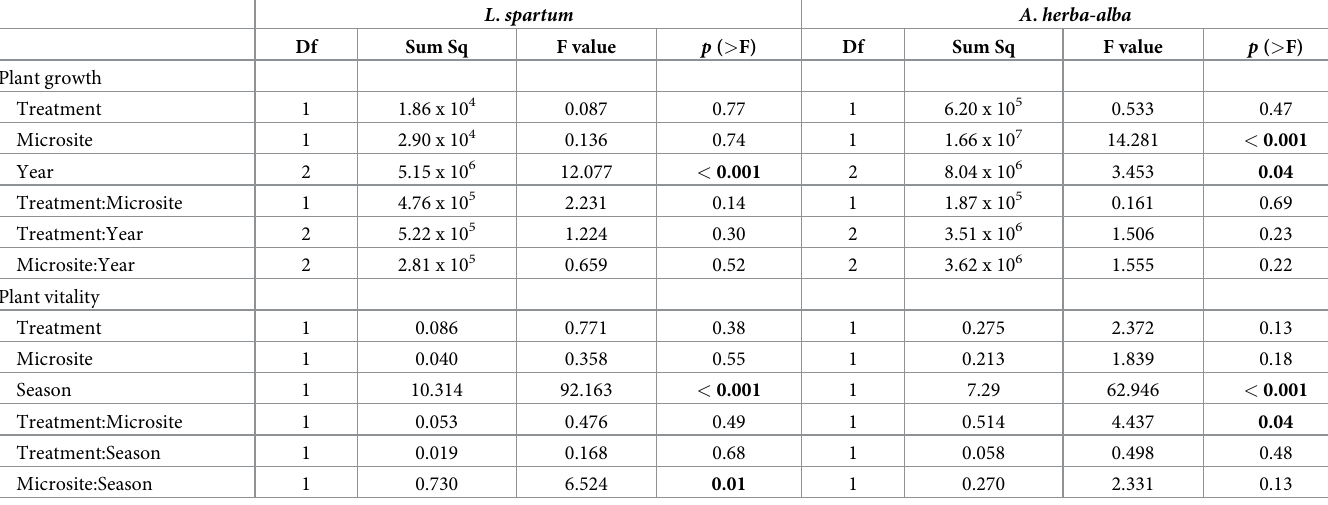
Table 1. Result of LMM analyses for the effect of treatment, microsite and time of measurement on the growth and vitality of target species. L .